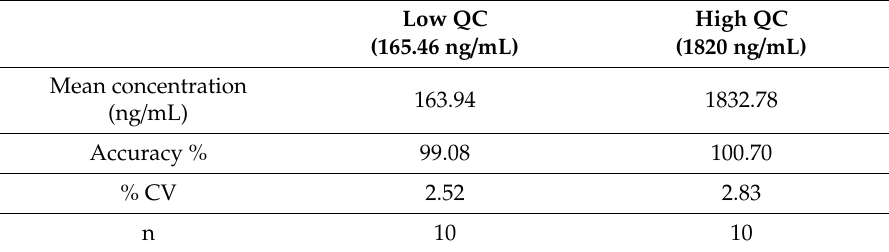
Table 2. Quality control (QC) results for MMAF (monomethyl auristatin F) in rat plasma.